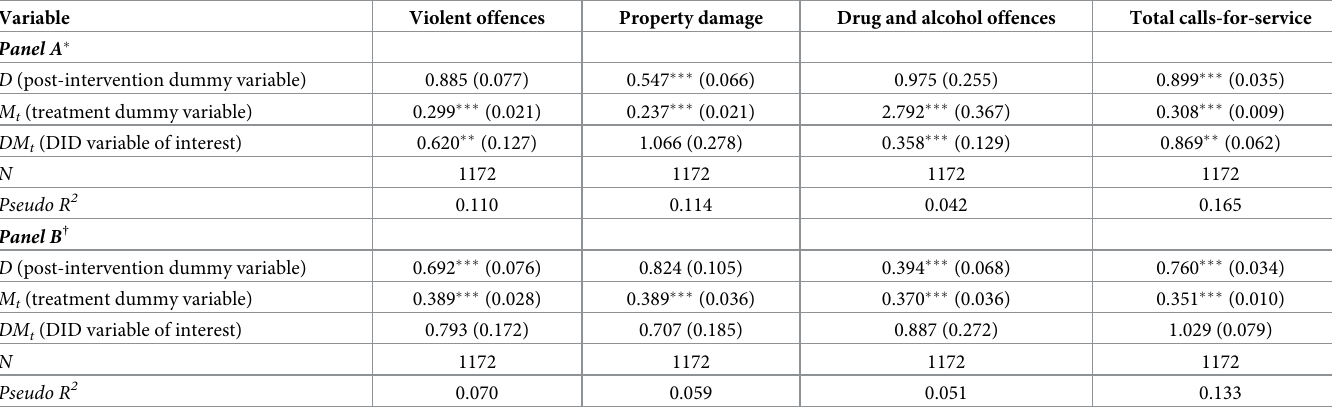
Table 3. DID analysis